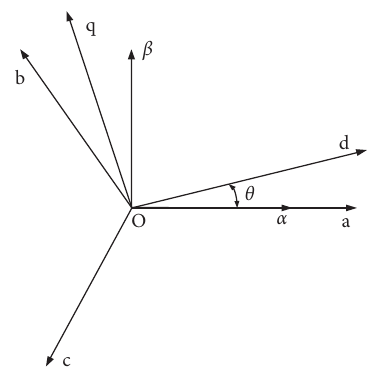
Figure 4: Space vector relation of three coordinate systems.